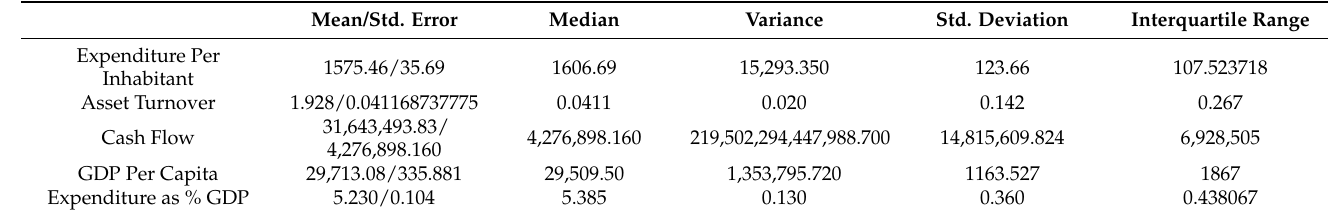
Table 4. Descriptive statistics model for regions with direct